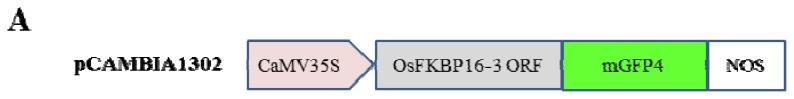
Subcellular localization of OsFKBP16-3 by transient expression of the green fluorescent protein (GFP) fused fluorescent proteins. (A) Structure of pCAMBIA 1302 binary constitutive expression vector harboring OsFKBP16-3; (B) Microscopic images of GFP, chloroplast autofluorescence and merged fluorescence from epidermal cells and protoplasts of Nicotiana benthamiana infected with Agrobacterium GV3101 harboring the GFP constructs. GFP alone (negative control) and GFP fused to OsFKBP16-3. The photographs were taken in the blue channel, red channel or combination. Bar = 10 μM.